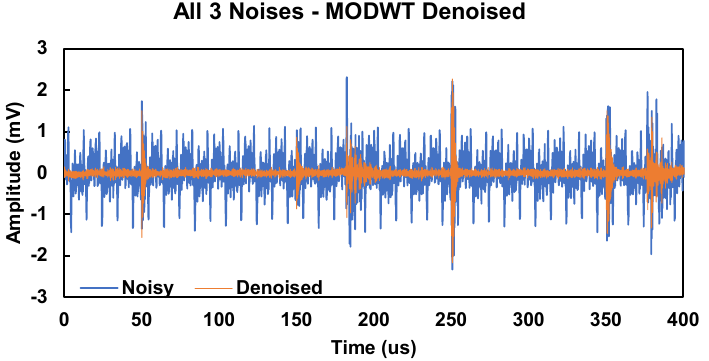
Figure 27. Denoised PD signal contaminated with the 3 types of noises simultaneously using MODWT. Input SNR = 0.43 dB and input NCC = 0.31, output SNR = 5.39 dB and output NCC = 0.84.